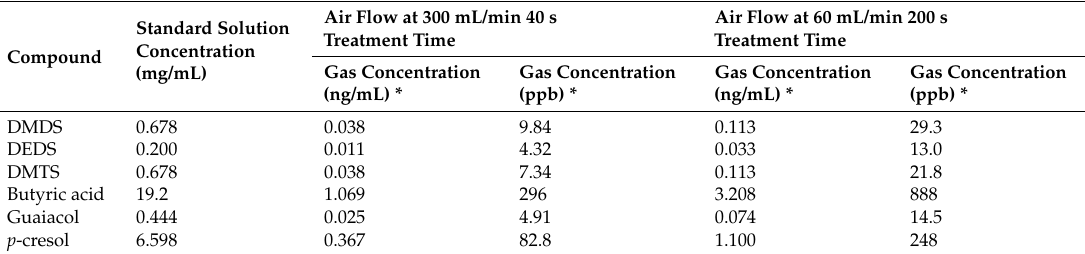
Table 2. Estimated standard gaseous concentration of odorant VOCs in treated flowing gas.